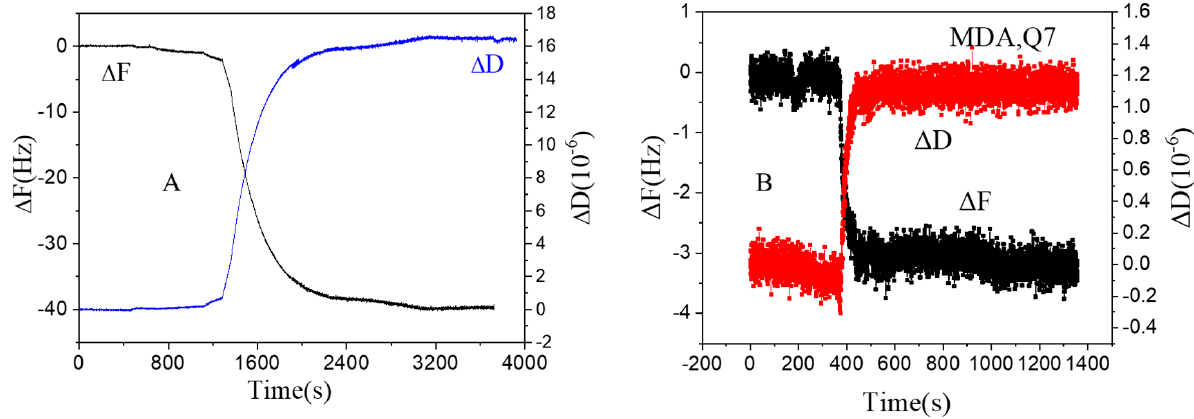
Figure 12. Variations in Δ F and Δ D with time upon addition of MDA; (MDA: 0.1 mmol·L − 1 ; Q[7]: 0.1 mmol·L − 1 ).